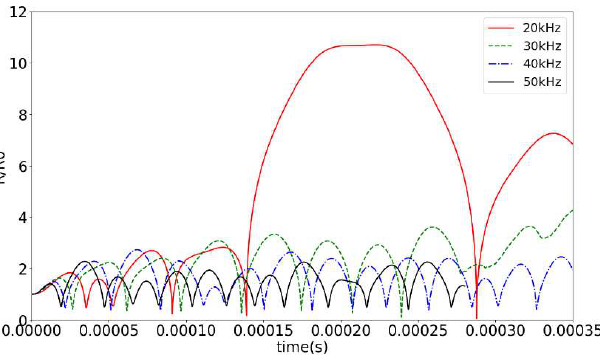
Figure 5. Dynamic curves of cavitations’ bubble in Ga-In alloy at different frequencies.